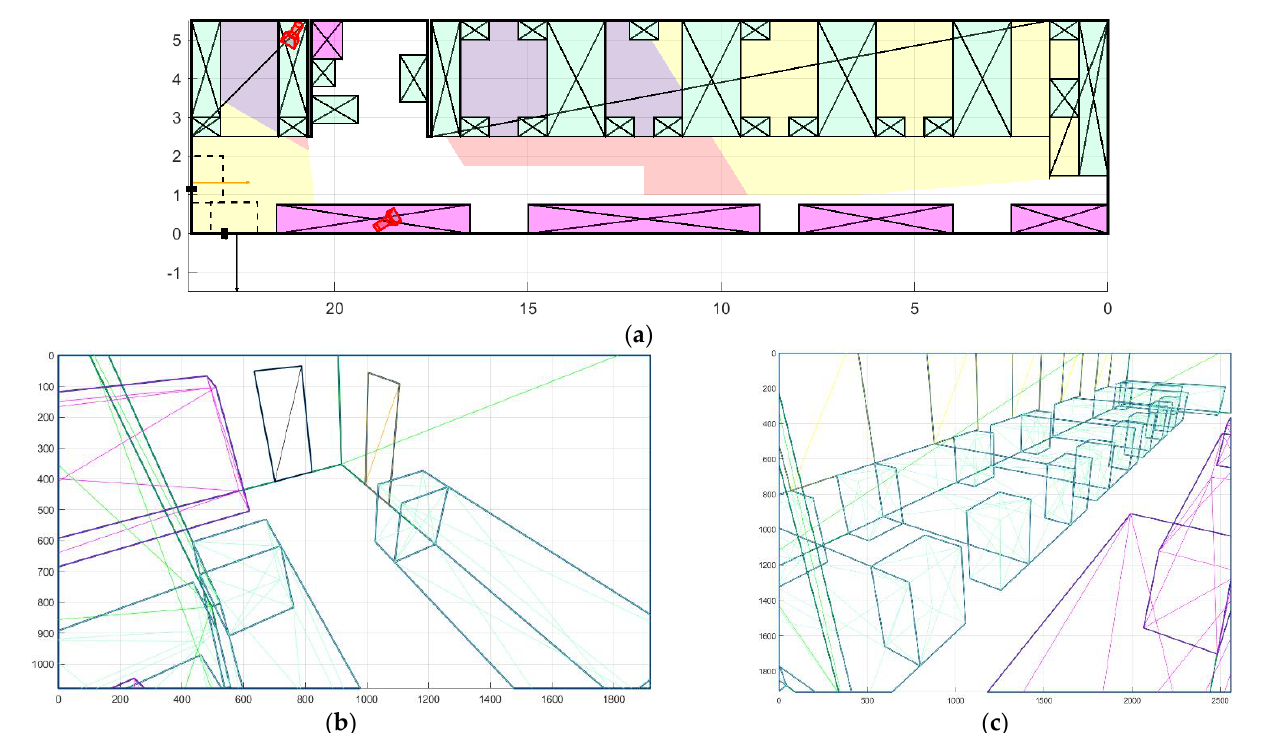
Figure 16. Placement of cameras with and without WDR, taking into account highlights in the room 2: ( a ) floor plan; ( b ) view from the first camera without WDR; ( c ) view from the second camera with WDR.